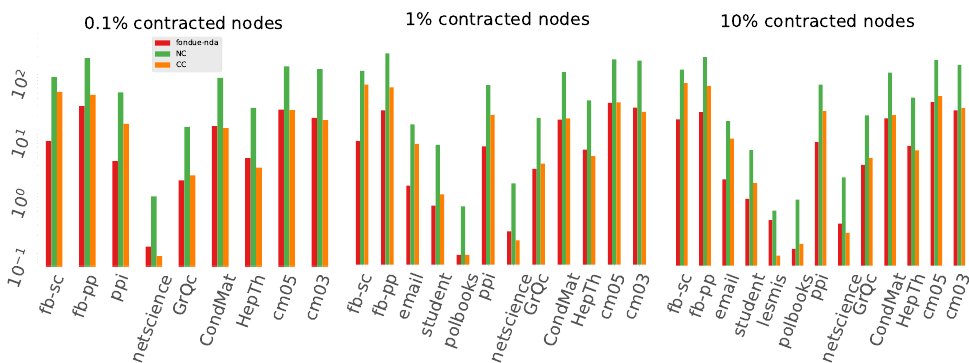
Figure 4. Bar plots for the runtime performance in seconds (lower is better) for each dataset listed in Table 7, for each of the 3 measures, FONDUE-NDA, NC, CC for different percentage of contracted nodes, 0.1%, 1%, and 10%, respectively. Table 7. Execution time (in seconds) comparison table for the different datasets averaged over 10 different experiments. The embedding time of the networks was not taken into account for the computation of the runtime results.